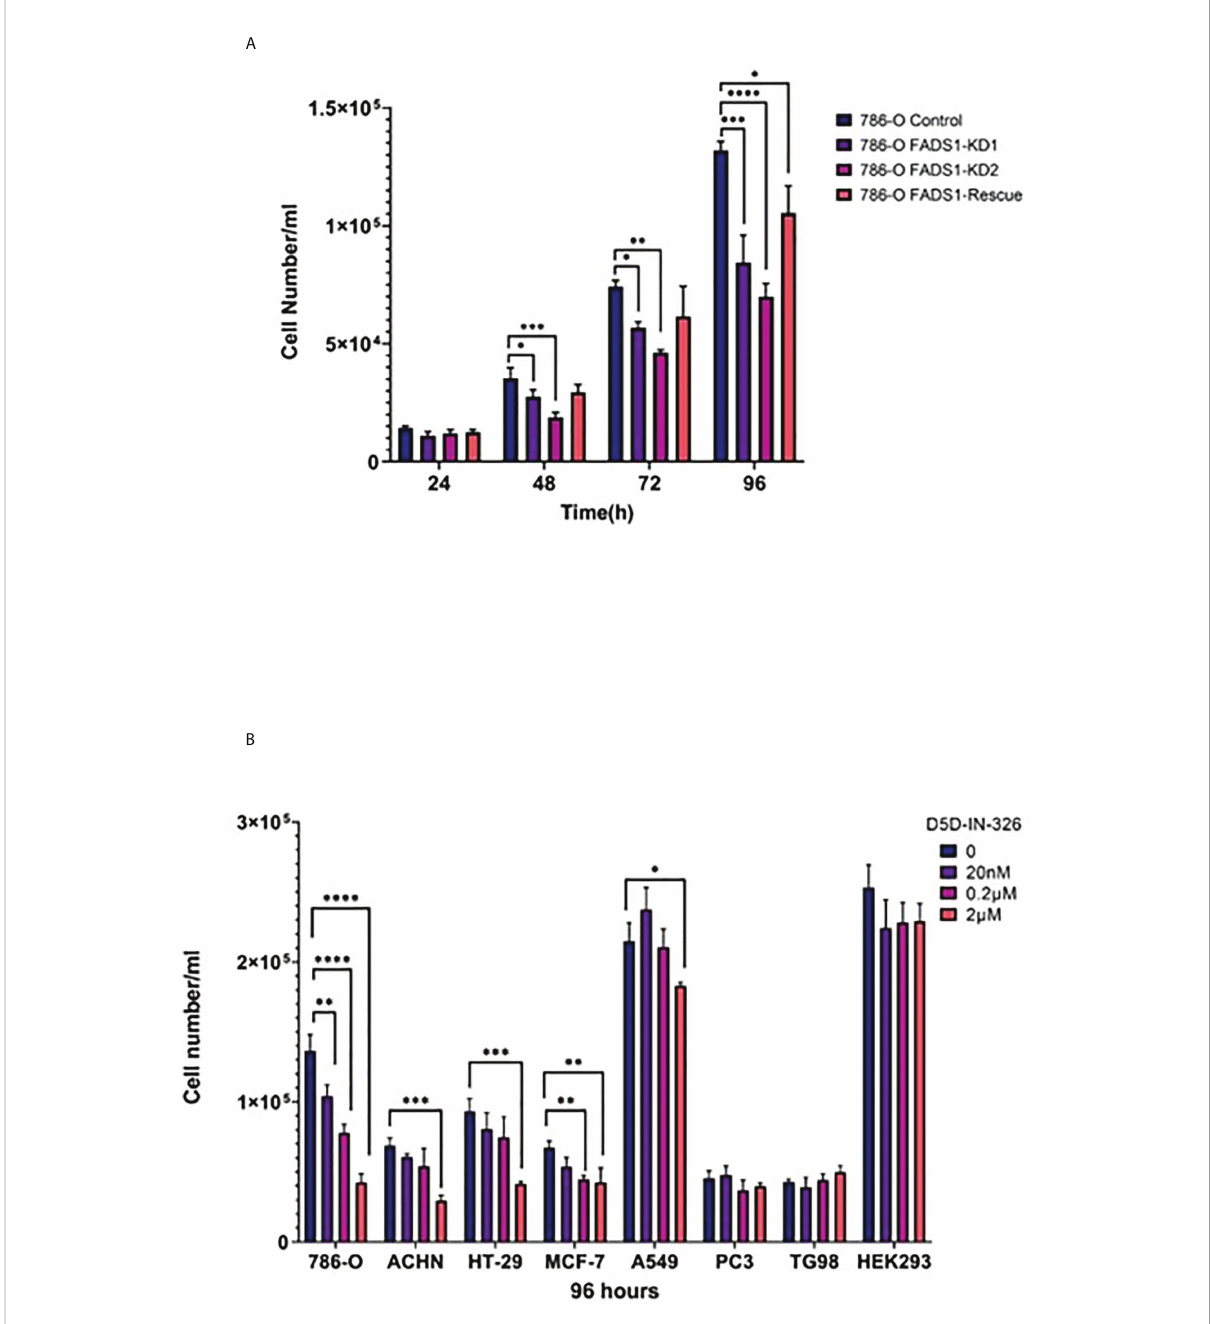
FIGURE 10 In vitro Study on FADS1. (A) Cell proliferation after FADS1 knockdown (KD) in 786-O cell line. (B) Cell proliferation in different cell lines. FADS1 inhibitor treatment in cancer cell lines at different doses after 96-hour treatment with FADS1 inhibitor. All experiments were performed in triplicates. *P<0.05, **P<0.01, ***P < 0.001,